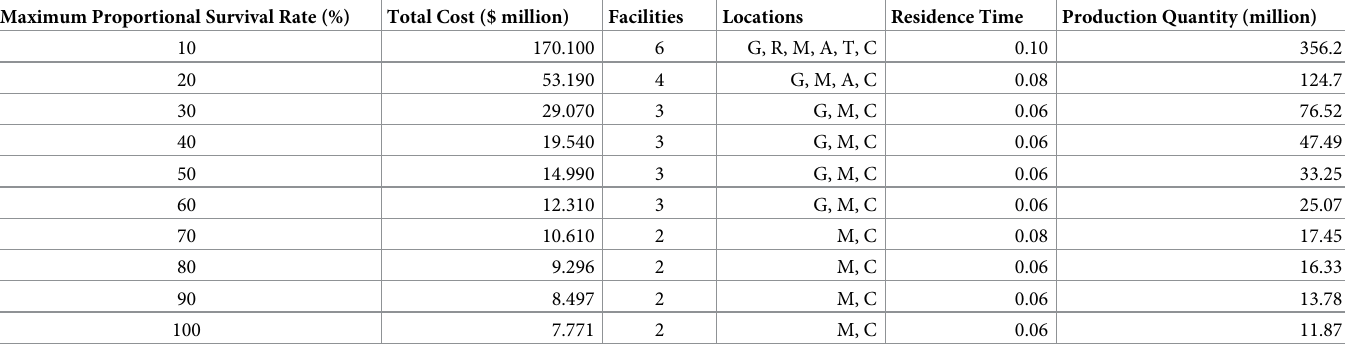
Table 3. Maximum proportional survival variance sensitivity. Sensitivity analysis results of maximum proportional survival rate on asymptotic survival function servic- ing base case subset of 50 reefs. The total cost, facility number and location, residence time, and production quantity are displayed for each. Locations are represented by the first letter of the names: Bundaberg (B), Gladstone (G), Rockhampton (R), Mackay (M), Airlie Beach (A), Townsville (T), and Cairns (C).